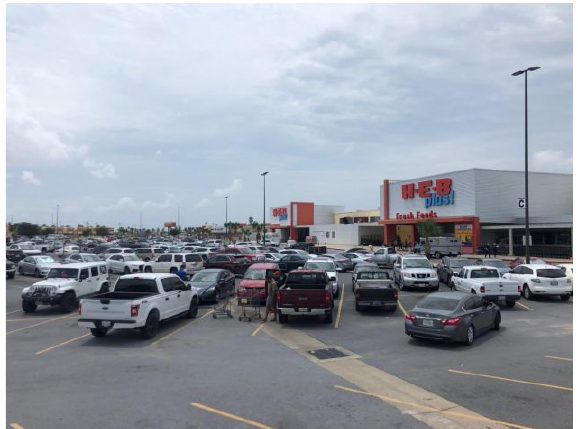
Fig. 5 Grocery store in Texas that retained power supply by a microgrid during the winter storm (Source: Courtesy of Enchanted Rock) [33]